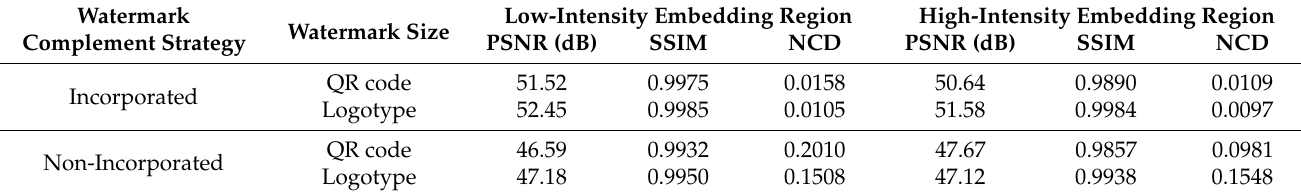
Table 3. Average quality and imperceptibility of the proposed